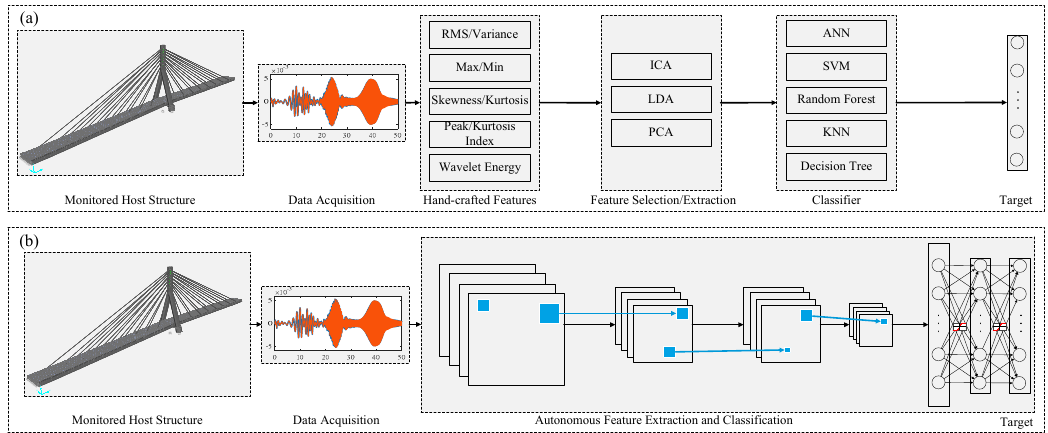
Figure 1. ( a ) Conventional data-driven SHM vs. ( b ) Deep learning-based SHM.